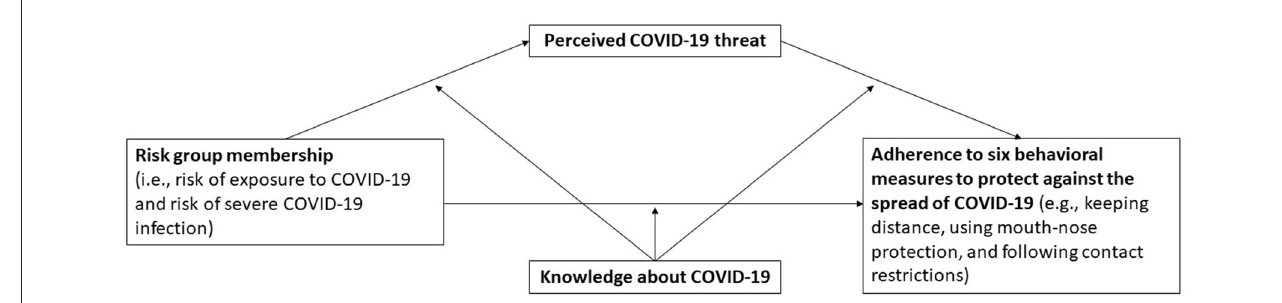
FIGURE 1 | Overview of the explored